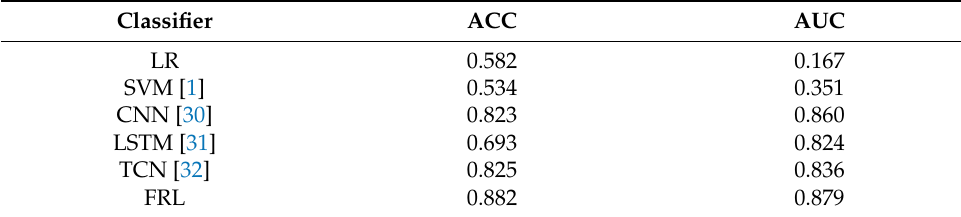
Table 3. Comparison of experimental results under different classifiers.